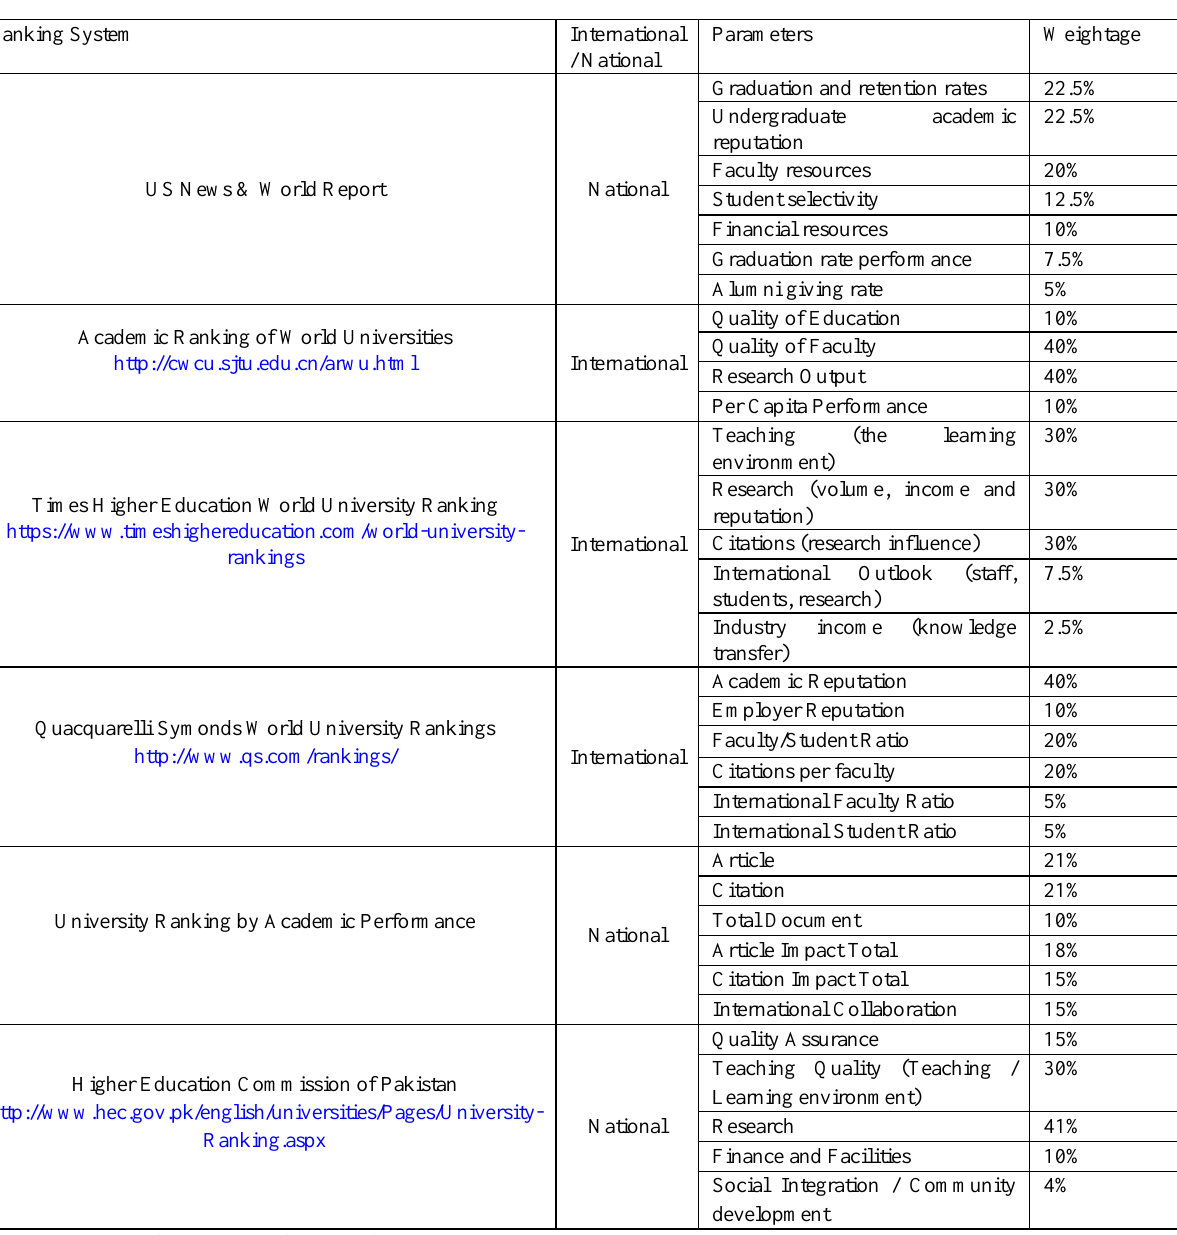
Table1: Summary of parameters of ranking frameworks